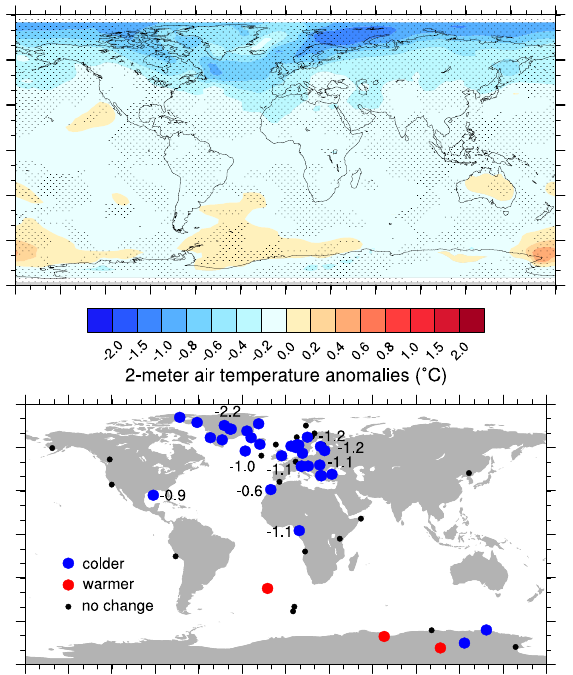
Fig. 8. (Top) Multi-model ensemble mean anomalies of annual- mean 2-meter air temperature in the first fifty years following the MWP relative to the control simulations, in degrees Celsius. Stippling shows grid cells where at least three of the simulations agree on the sign of the temperature anomaly. (Bottom) Qualita- tive and quantitative mean-annual temperature anomalies relative to the early Holocene background climate, in degrees Celsius, inferred from proxy records for the 8.2ka event, as summarized by Morrill et al. (2013).